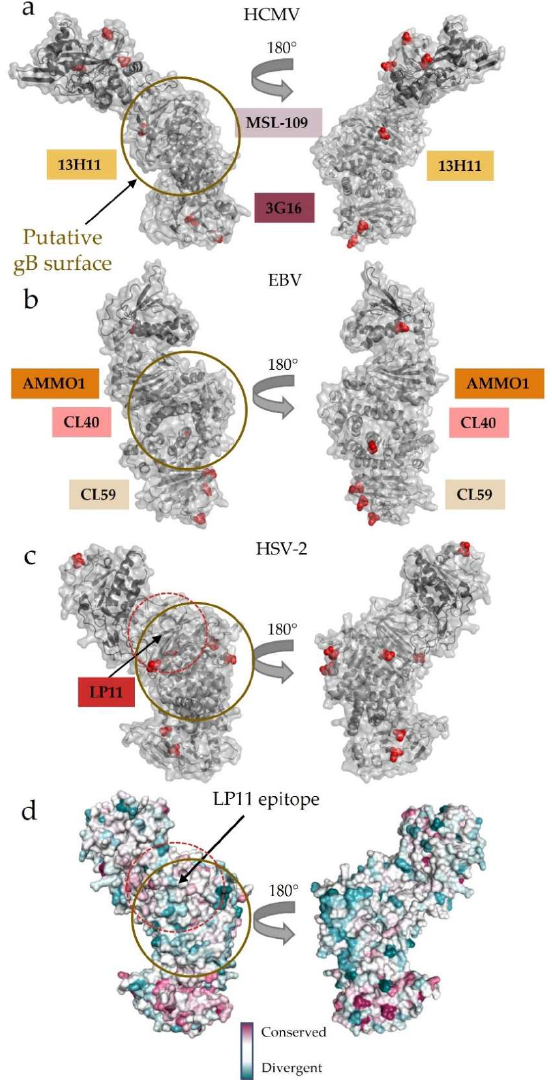
Figure 6. Surface conservation and glycosylation patterns pinpoint the putative gB-binding region. ( a – c ) Glycosylation patterns across ( a ) HCMV, ( b ) EBV, and ( c ) HSV-2 gH/gL. The putative gB- binding face, as postulated initially in HSV-2, is remarkably free of glycosylation across the human herpesvirus gH/gL structures currently known. The binding locations of neutralizing antibodies that do not affect host cell receptor binding are indicated along the edge of the heterodimer. These antibodies bind DII, DIII, and DIV in HCMV and EBV gH/gL, while LP11 binds HSV-2 gH/gL at the “kink” between H1 and H2. ( d ) Surface conservation across herpesviruses mapped onto the HSV-2 gH/gL structure. The N terminus, which is used to engage a wide variety of host-cell receptors and receptor adaptors, is more divergent than the C terminus. The wide face of gH/gL, where LP11–an antibody that disrupts gB-gH/gL interactions–binds is more conserved than the opposite face of the complex. All human herpesviruses require gH/gL and gB interactions to trigger